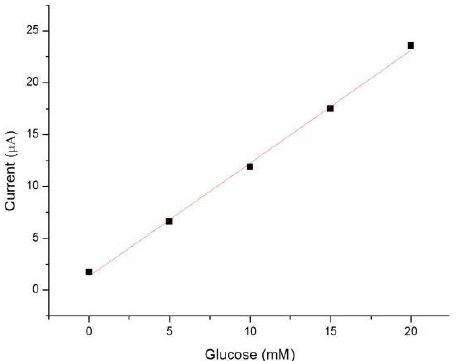
Figure 6. The calibration plot for the measurement of